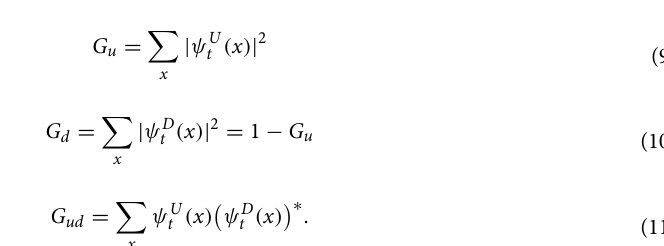
Figure 3. Von Neumann entanglement entropy S e versus ( a , b ) time, ( c , d ) C . Other parameters displayed in the 500 and each point is an average over 100 panels. For ( c , d ) S e is computed at t =